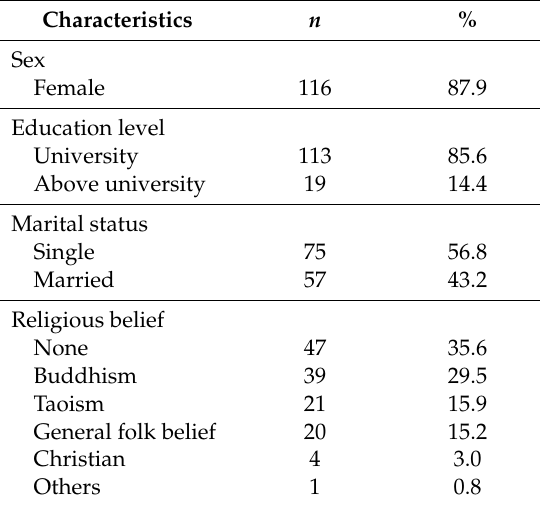
Table 1. Demographic characteristics of